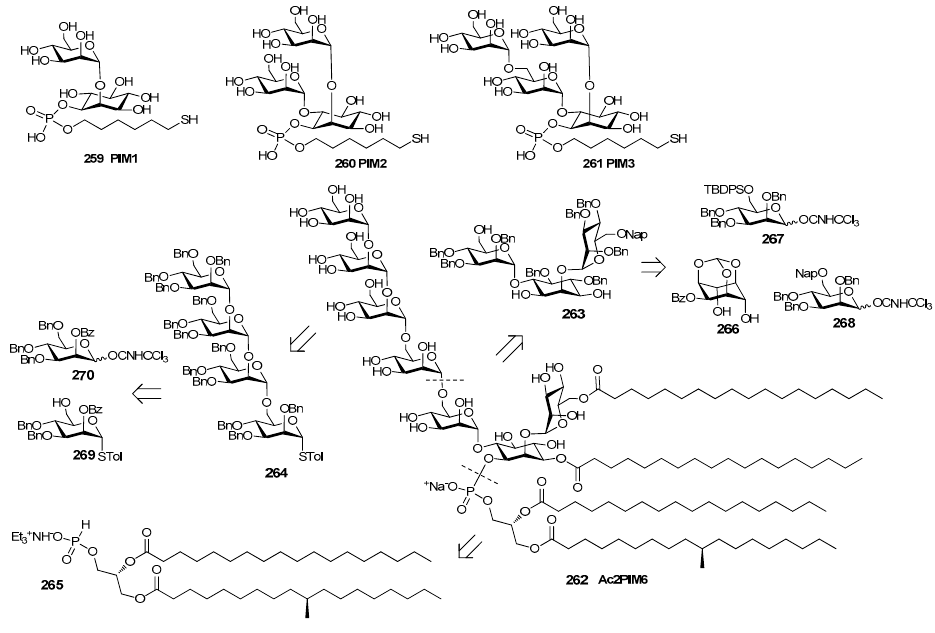
Figure 28. Phosphatidylinositol mannosides (PIMs) and retrosynthetic route of